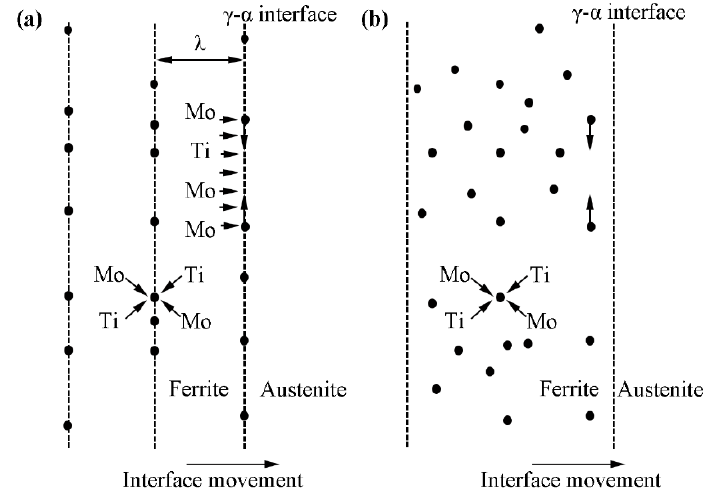
Figure 8. Schematic diagrams showing the relationship between precipitation morphology and the velocity of γ / α interface ( a ) interphase precipitation, ( b ) supersaturated precipitates.